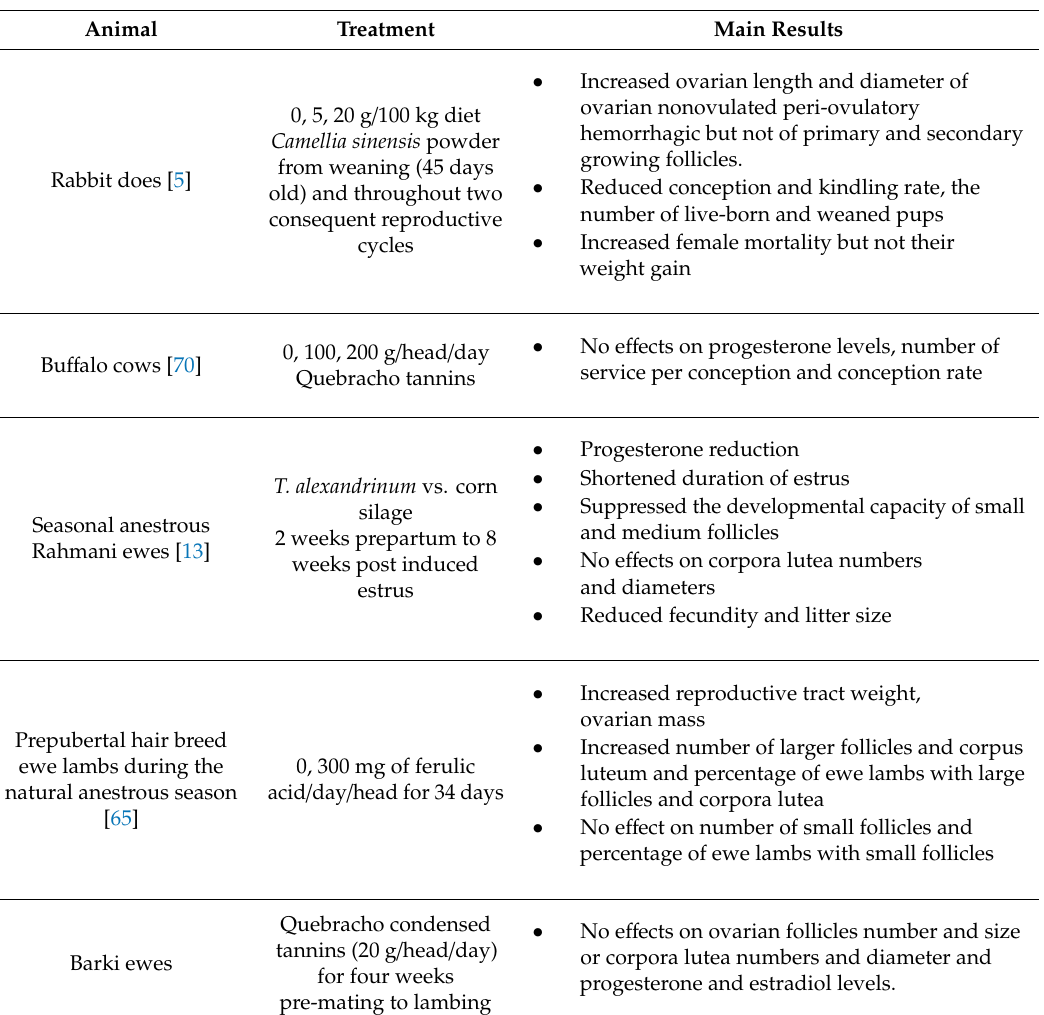
Table 3. Summary of some recent in vivo studies on the e ff ects of polyphenols on reproductive performance of female farm